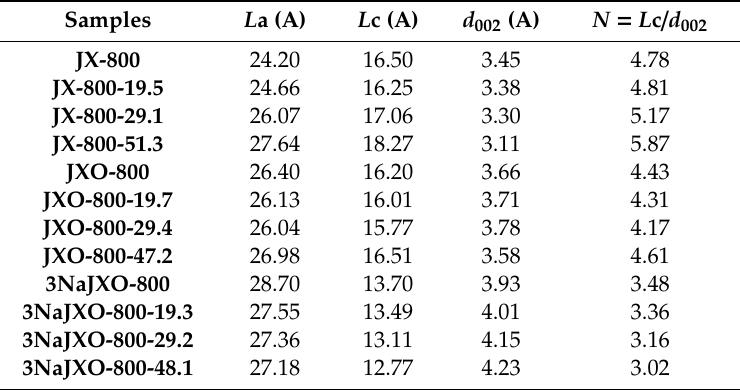
Table 3. XRD data of typical chars at di ff erent burn o ff